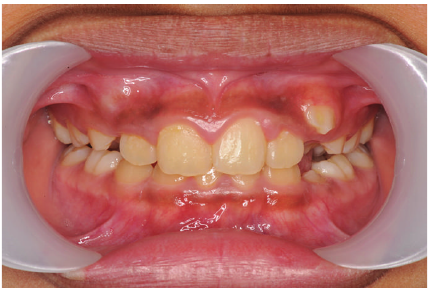
Figure 3: Upper occlusal photograph showing crowded permanent canines.